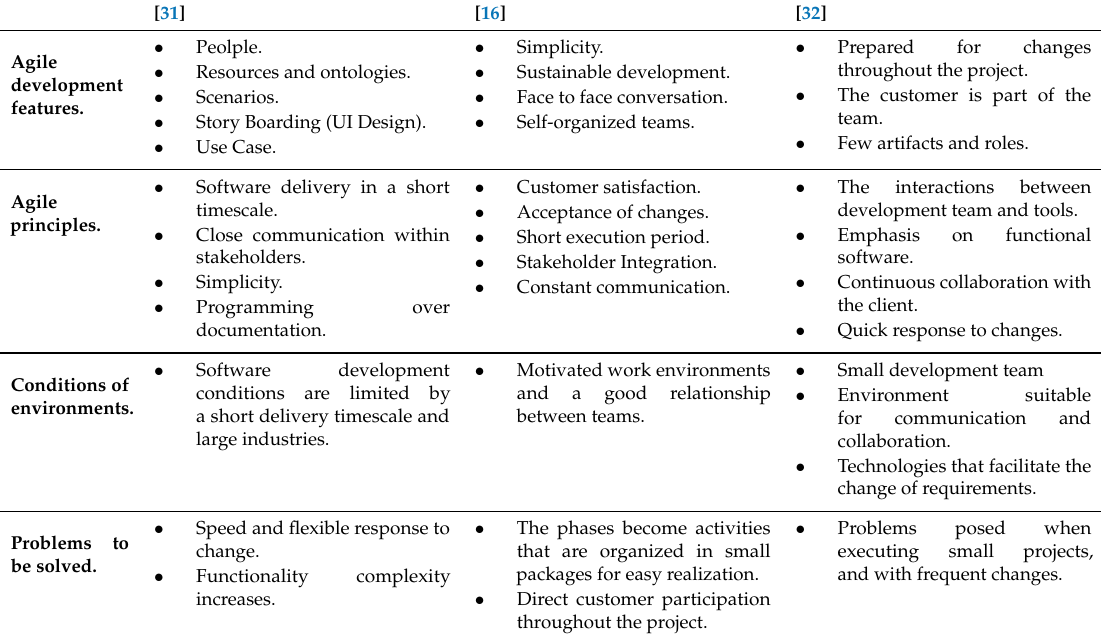
Table 6. Analysis of agile characteristics in development considered in primary studies